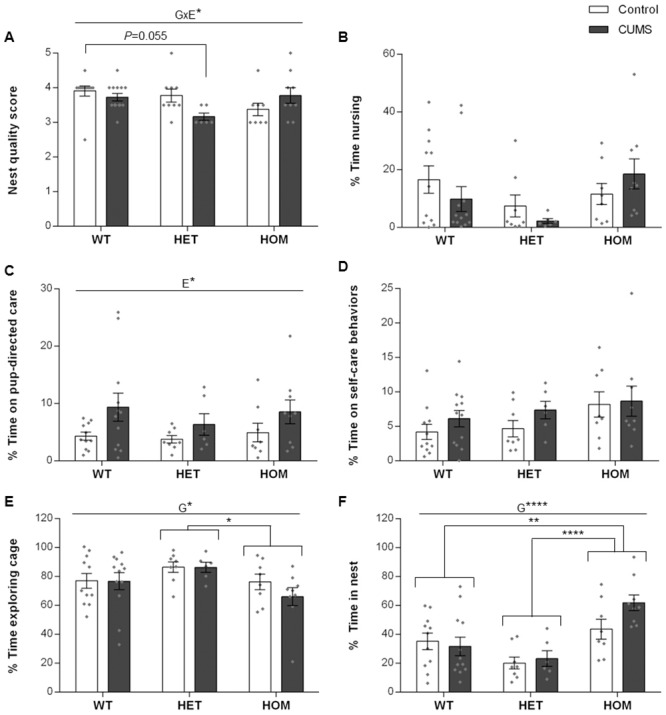
Exposure to CUMS increased pup-directed care and Shank3ex4-9 mutant dams exhibited more maternal in-nest care behaviors.(A): Nest quality scores. A significant G×E interaction was observed, likely driven by a lower nest quality in CUMS-exposed HET dams; (B): Percent time dams spent nursing. Genotype and exposure did not affect the amount of nursing time spent by dams; (C) Percent time dams engaged in pup-directed care behaviors. CUMS exposure significantly increased the amount of time dams spent on pup-directed behaviors; (D): Percent time that dams spent engaging in self-care. CUMS exposure or genotype did not affect the time dams spent in self-care; (E): Time spent in cage exploration. CUMS exposure did not alter the time dams spent in cage exploration, but there was a significant genotype effect with HOM dams spending less time exploring their cage compared to HET dams; (F): Percent time in nest. HOM dams spent more time in the nest compared to WT and HET dams, and CUMS exposure did not affect this difference. WT: Wildtype; HET: Heterozygous; HOM: Homozygous; N for nest quality = Control (11 WT, 9 HET, and 8 HOM) and CUMS (13 WT, 6 HET and 9 HOM). N for maternal care: Control (11 WT, 8 HET, and 8 HOM) and CUMS (12 WT, 6 HET, and 9 HOM). G: Main effect of genotype, E: Main effect of exposure, G×E: Genotype × exposure interaction; Individual data points are represented by diamonds. *P < 0.05, **P < 0.005; ****P < 0.0001.